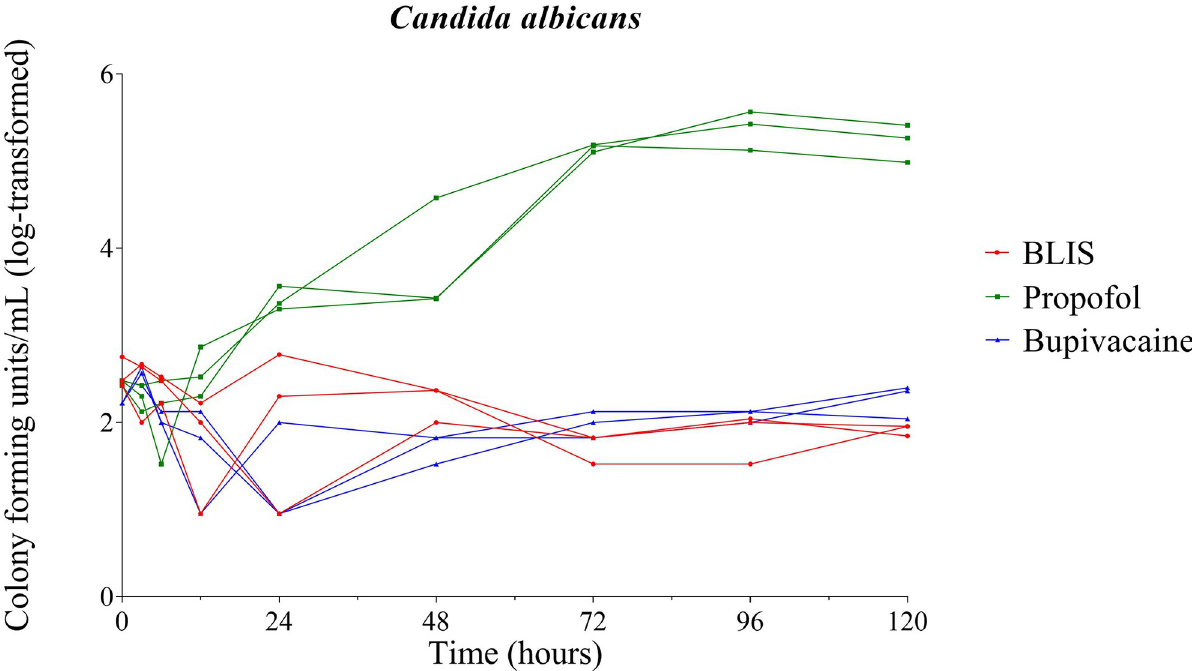
Fig 4. Growth dynamics of Candida albicans . Growth of inoculated Candida albicans over time in bupivacaine liposomal injectable suspension (BLIS), propofol, and bupivacaine 0.5%. Each line represents an individual vial; red lines represent BLIS, green lines represent propofol, and blue lines represent 0.5% bupivacaine.